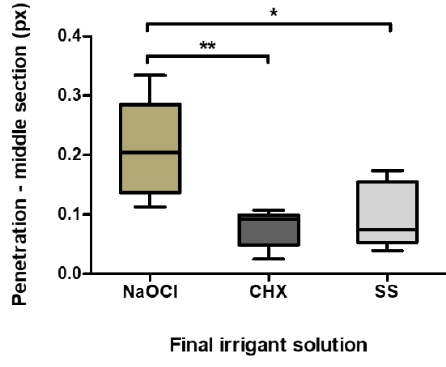
Figure 4. Sealer penetration in the middle sections (pixels). The boxplot shows the mean, minimum and maximum penetration of the different irrigants in the apical section. * p = 0.031; ** p = 0.004.